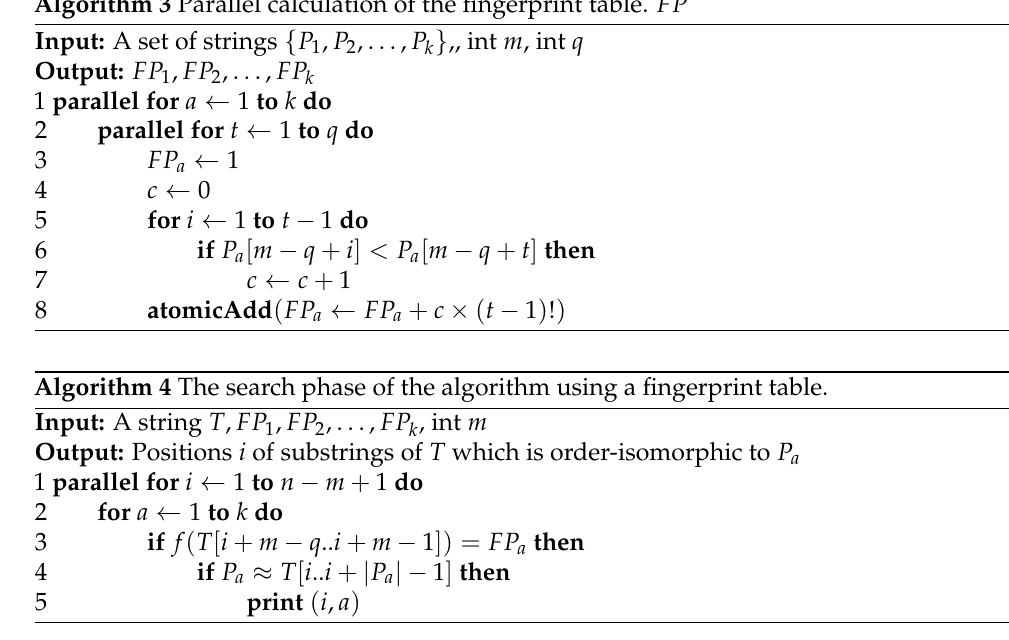
Algorithm 3 Parallel calculation of the fingerprint table. FP